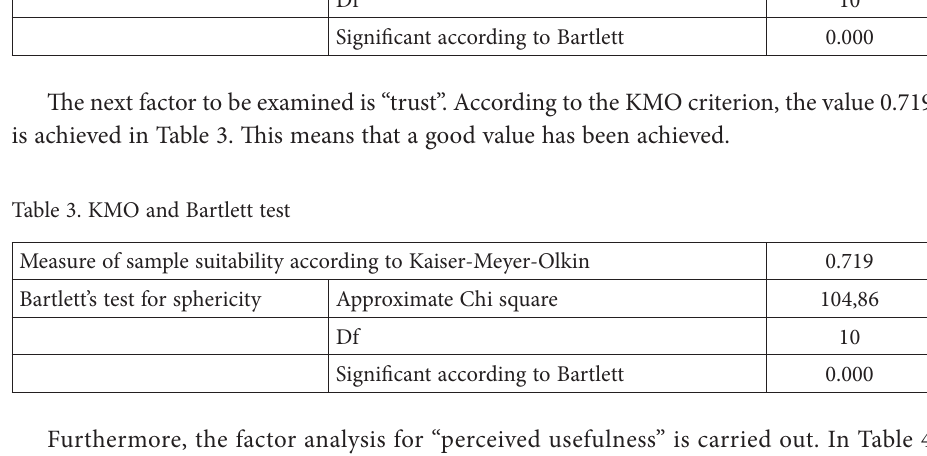
Table 2. KMO and Bartlett test Measure of sample suitability according to Kaiser-Meyer-Olkin 0.600 Bartlett’s test for sphericity